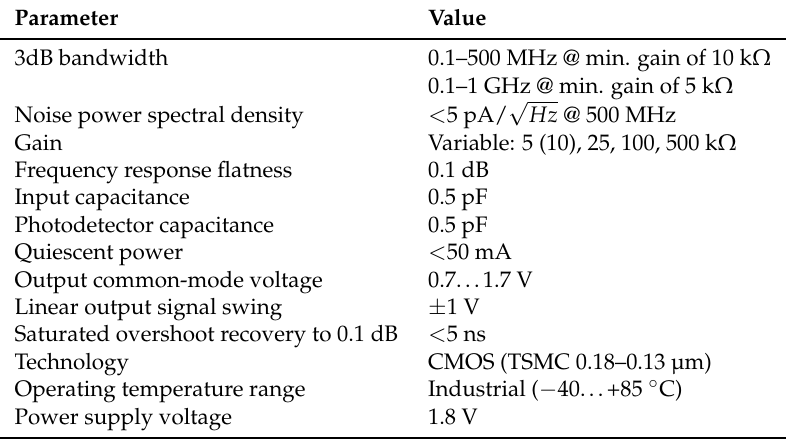
Table 1. Preliminary CMOS TIA specification for OTDR